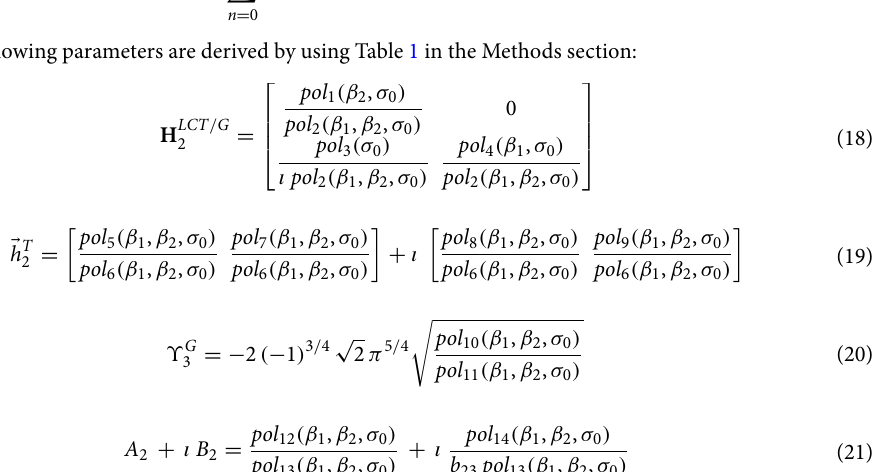
1 (ns) by varying the ratio of t 01 c with t 01 = × =